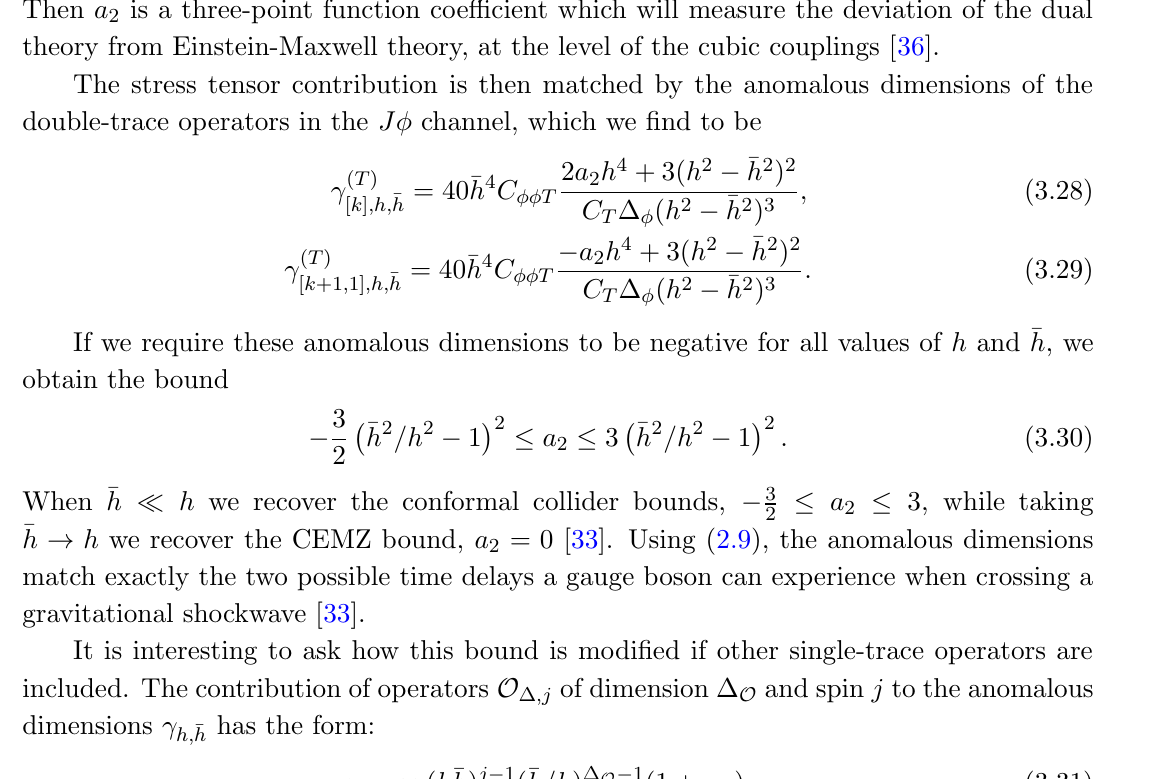
(cid:20) 0 as a function of (cid:22) h=h h; (cid:22) h